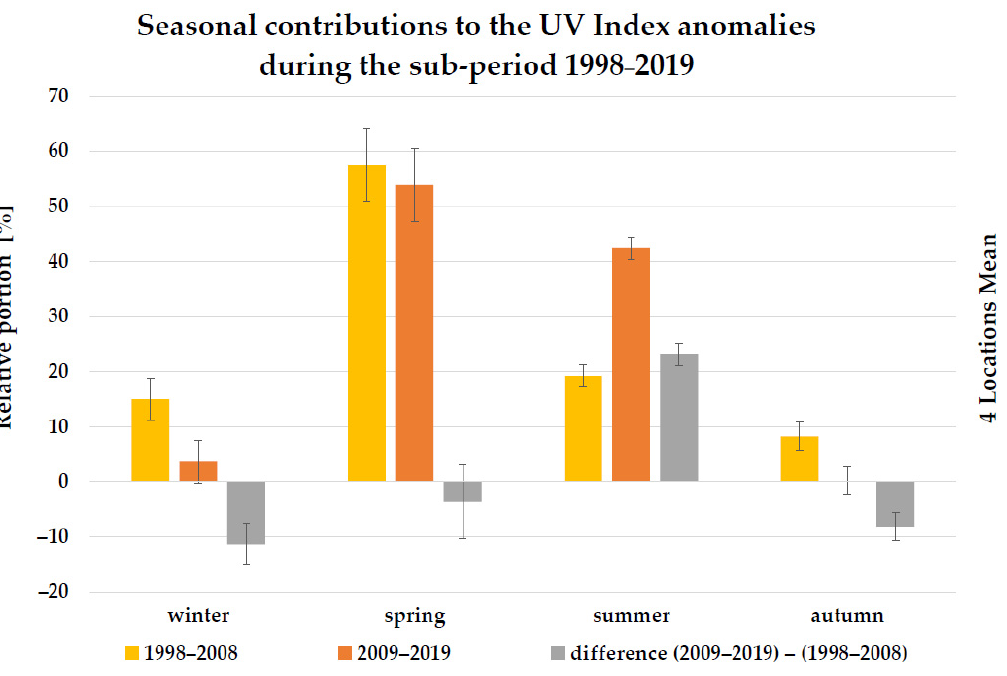
Figure 11. Seasonal contributions to the UV index anomalies during period T3 and changes between the 1998–2008 and 2009–2019 subperiods of T3 (4-location means and standard deviations).